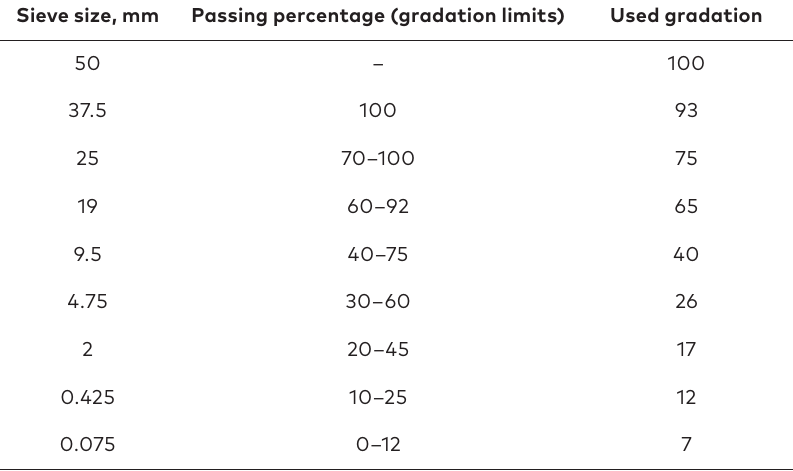
Table 5. Aggregate gradation used in the granular base